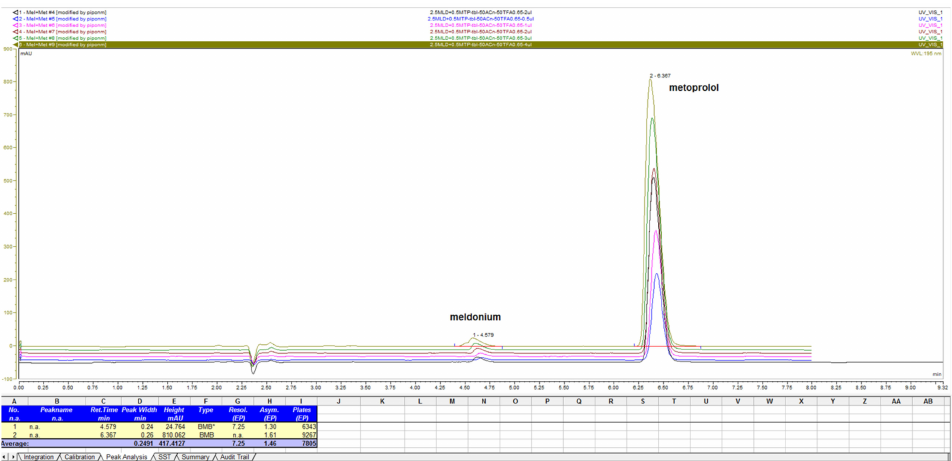
Figure 22. Dionex-Full scale overlaid chromatograms linearity of method with Waters Spherisorb CNRP-250 × 4.6 mm and 50% ACN and 50% diluted TFA at 195 nm, with system suitability parame- ters in table